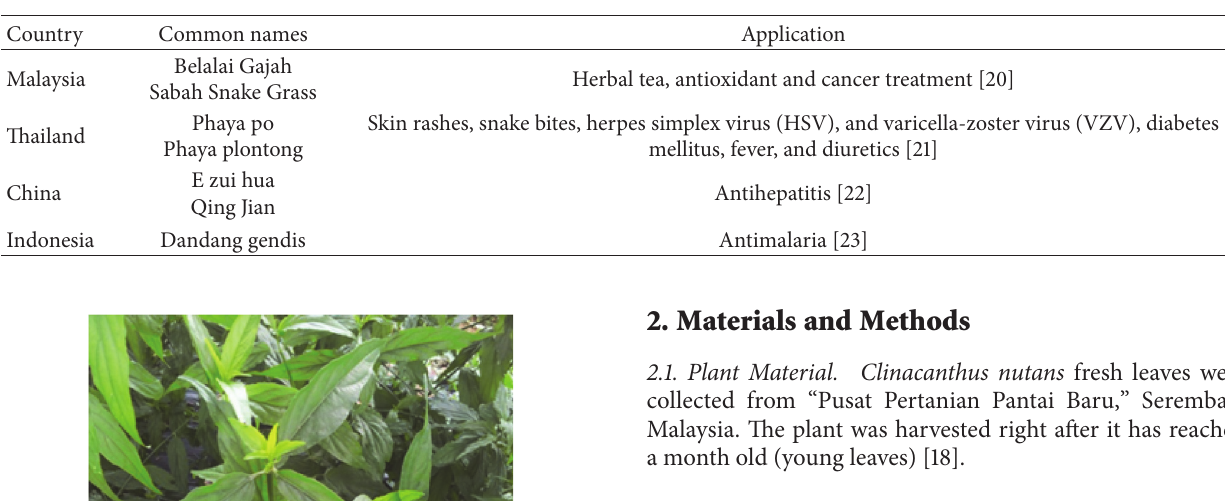
Table 1: Common names and traditional use of Clinacanthus nutans [10].